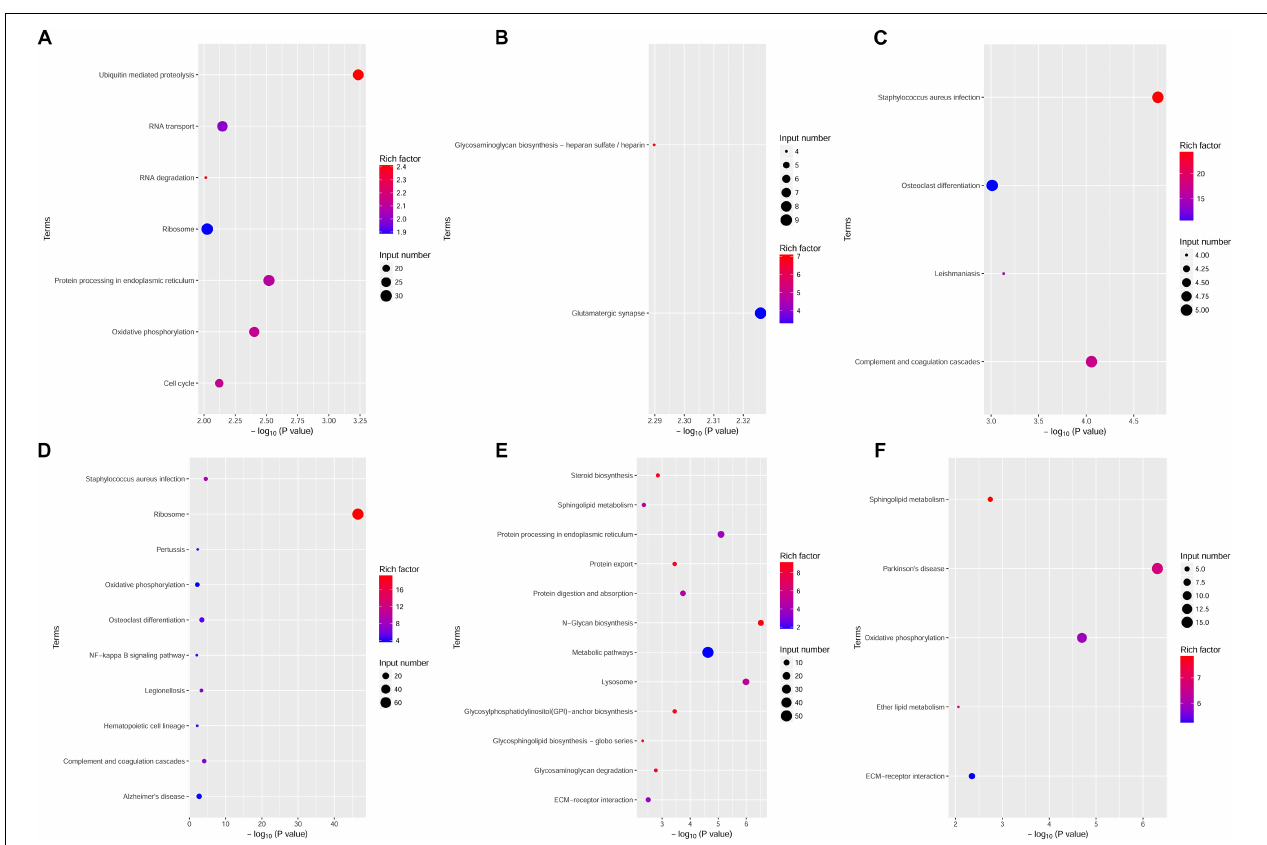
FIGURE 5 | KEGG pathway enrichment analysis of upregulated and downregulated DEGs at various time points. The dot size and depth indicate the number of DEGs contained in the KEGG pathway and the degree of enrichment of the rich factor, respectively. We chose the most significant top 20 GO terms according to –log10 ( P -value). (A–C) KEGG analysis of upregulated DEGs at 6, 12, and 24 h. (D–F) KEGG analysis of downregulated DEGs at 6, 12, and 24 h. Rich factor: the enrichment factor of KEGG pathway enrichment analysis of DEGs; Input number: the number of genes enriched in this pathway in the list of differentially expressed